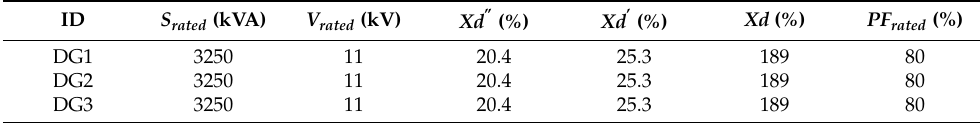
Table A1. Distributed Generator Data.